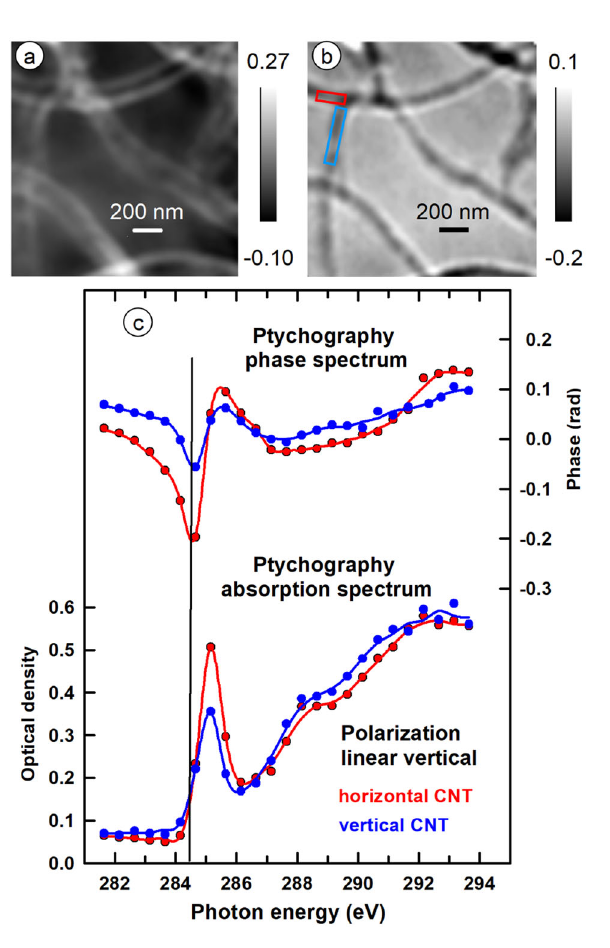
Fig. 5 Carbon K-edge phase imaging and phase and absorption spectroscopy of the CNT sample. a Average over the phase images at all photon energies from a C 1 s energy stack (282 – 296 eV, 0.5 eV spacing) recorded using defocus ptychography with a 1.0 μ m spot size. A scale factor of − 1 was applied. b Phase image at 284.7 eV, corresponding to the C 1 s → π * absorption resonance. c Comparison of phase and amplitude spectra taken from the areas indicated by red and blue rectangles in ( b ). Linear vertical polarization, which highlights horizontal CNT, was used. The lines are smoothed versions of the measured data (points). The vertical line highlights the energy of the minimum of the C 1s → π * phase resonance, which is 0.5eV below the peak of the C 1s → π * resonance in the absorption spectrum. (see Supplementary Table 1 for acquisition